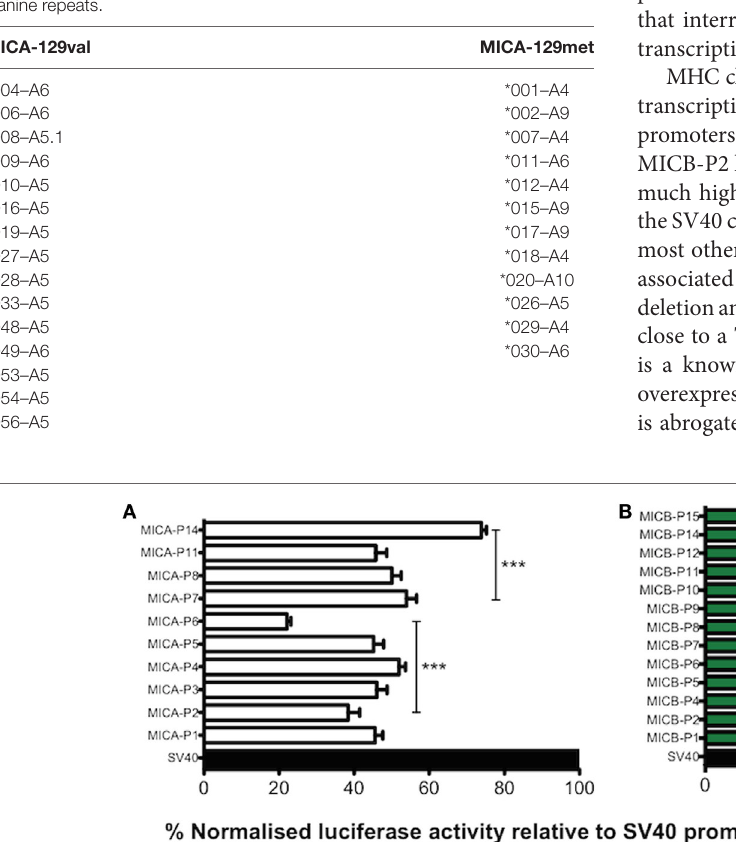
FigUre 7 | Transcriptional analysis of MHC class I-related chain A (MICA) and MHC class I-related chain B (MICB) promoter regions in proliferating HCT116 cells. Normalised percent luciferase activity relative to SV40 control plasmid transfection is shown. Assay conditions were performed in triplicate with three independent preparations of plasmid construct DNA and repeated for a total of four independent experiments. (a) MICA promoter driven luciferase transcription relative to SV40 promoter in proliferating HCT116 cells 24 h post-transfection. (B) MICB promoter driven luciferase transcription relative to SV40 promoter in proliferating HCT116 cells 24 h post-transfection. Statistical analysis was performed using Mann–Whitney test ± SEM (** P < 0.01 and *** P < 0.001).